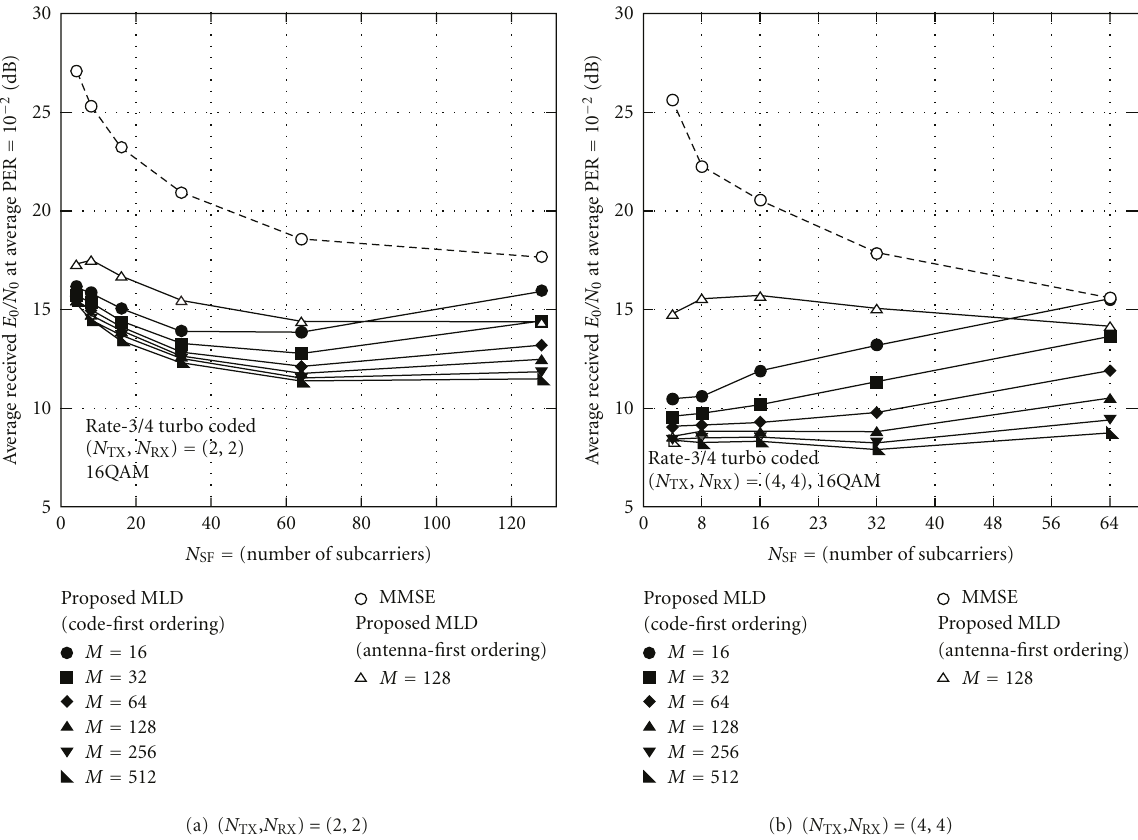
Figure 8: Required average received E b /N 0 as a function of N SF (coded